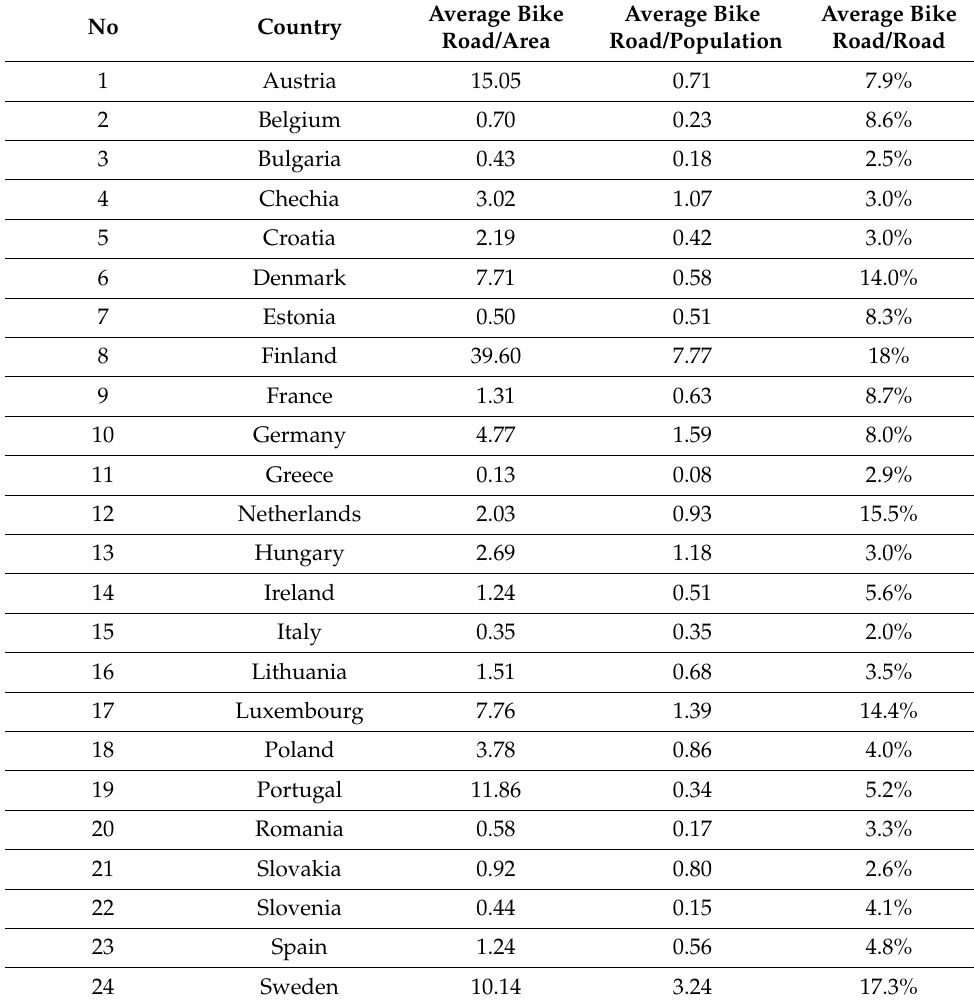
Table 5. European countries—bike path saturation in the surveyed smart cities. No Country